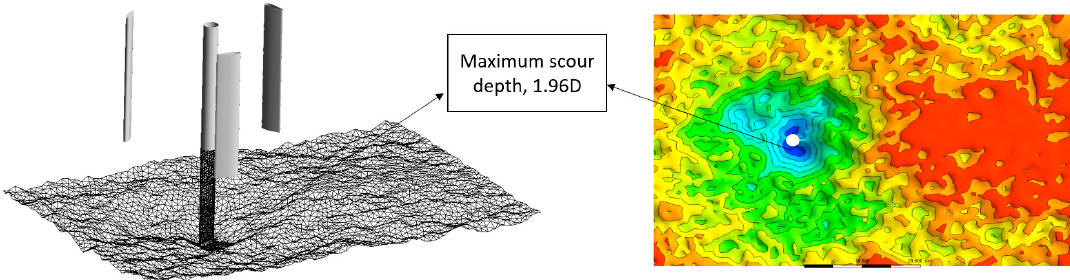
Figure 16. Equilibrium scour profiles around full-scale turbine: the maximum scour depth is 1.96 D .